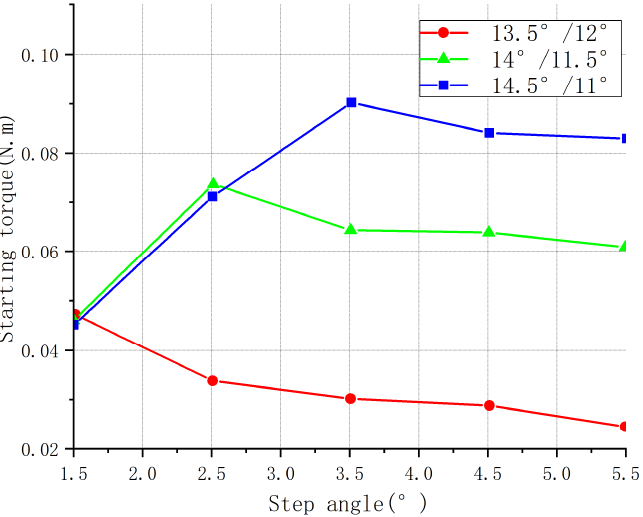
Figure 5. Starting torque of different step angles for three parameter combinations.